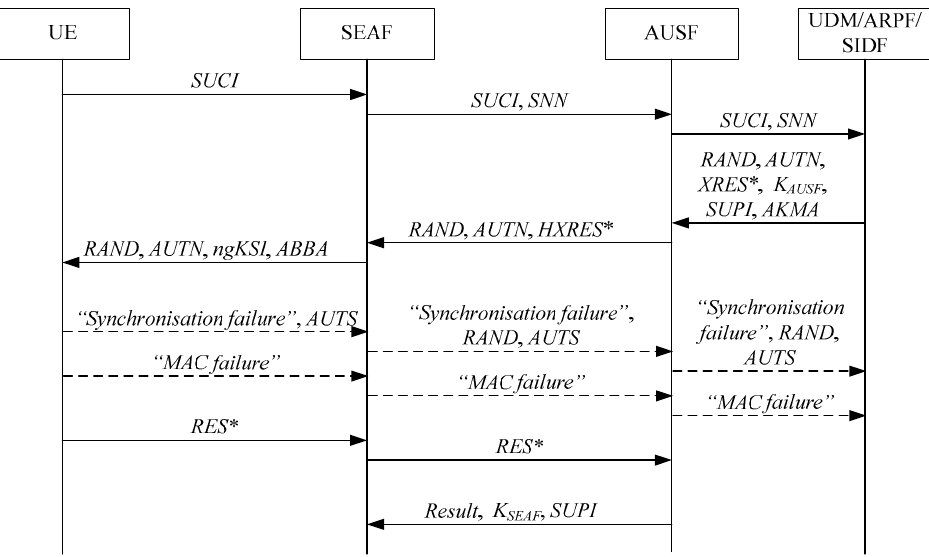
Figure 1. The steps of the latest version of the 5G AKA protocol. In the following notations, various fields in the figures have been described, including these fields marked with *. In detail, XRES is an expected response, while XRES ∗ is an expected response from XRES , then HXRES ∗ is a hashing expected response from XRES ∗ . RES is response, while RES ∗ is a response from RES